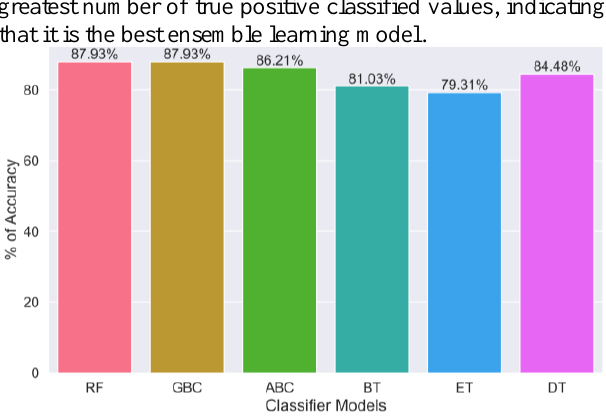
Figure 14. Linear Machine Learning Classification Models